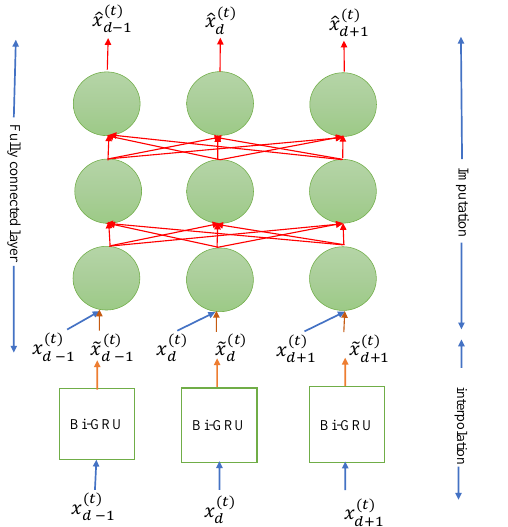
Figure 5. E-TMP-GNN II.